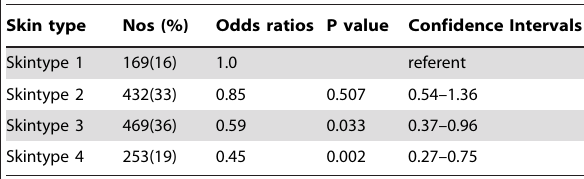
Table 1. Odds ratios for vitamin D levels equal or below 70 nmol/L according to skin type (adjusting for age, BMI, season of sampling, total number of weeks of sunny holidays and sunbed